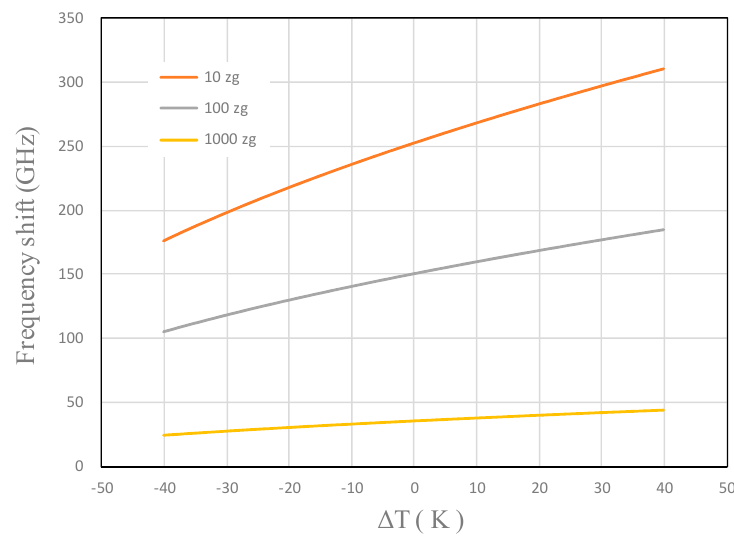
Figure 4. Variation of the vibration frequency shift with the temperature difference for different nanomass sizes ( e 0 a = 2.0 nm, ξ = η = 0.5).